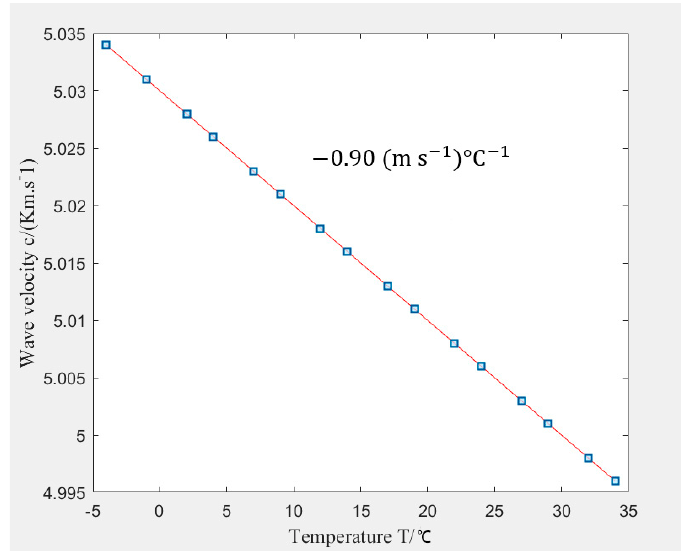
Figure 11. Temperature effect on Lamb wave velocity (R)